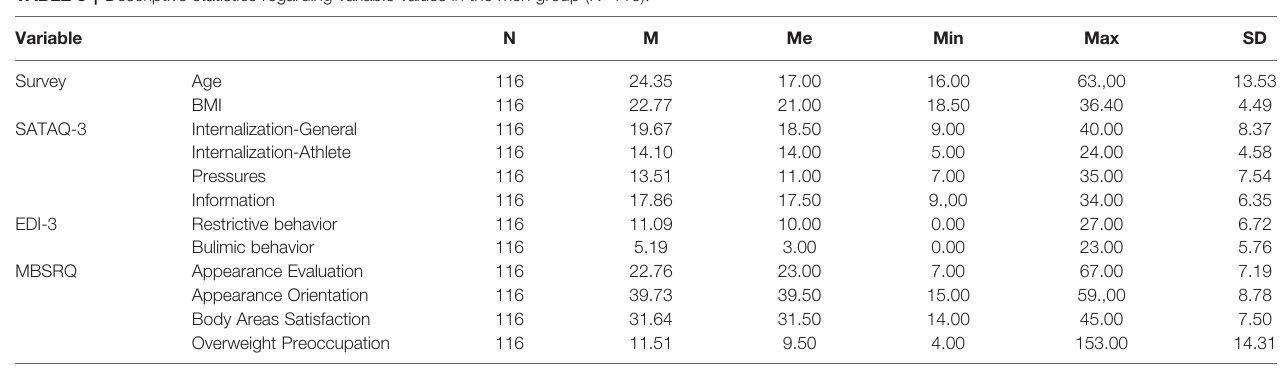
TABLE 3 | Descriptive statistics regarding variable values in the men group (N=116). Variable Survey